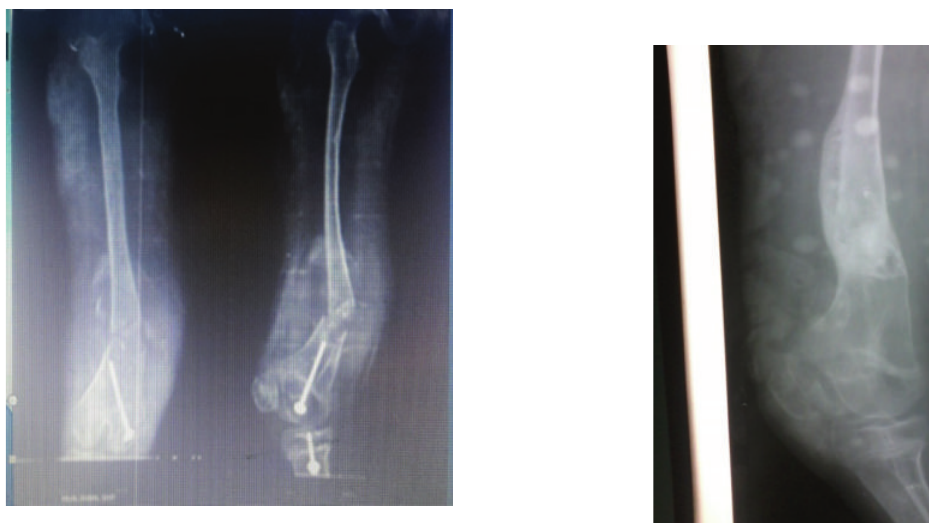
Figure 3: Two and half months postoperative X-ray showing good amount of callus.